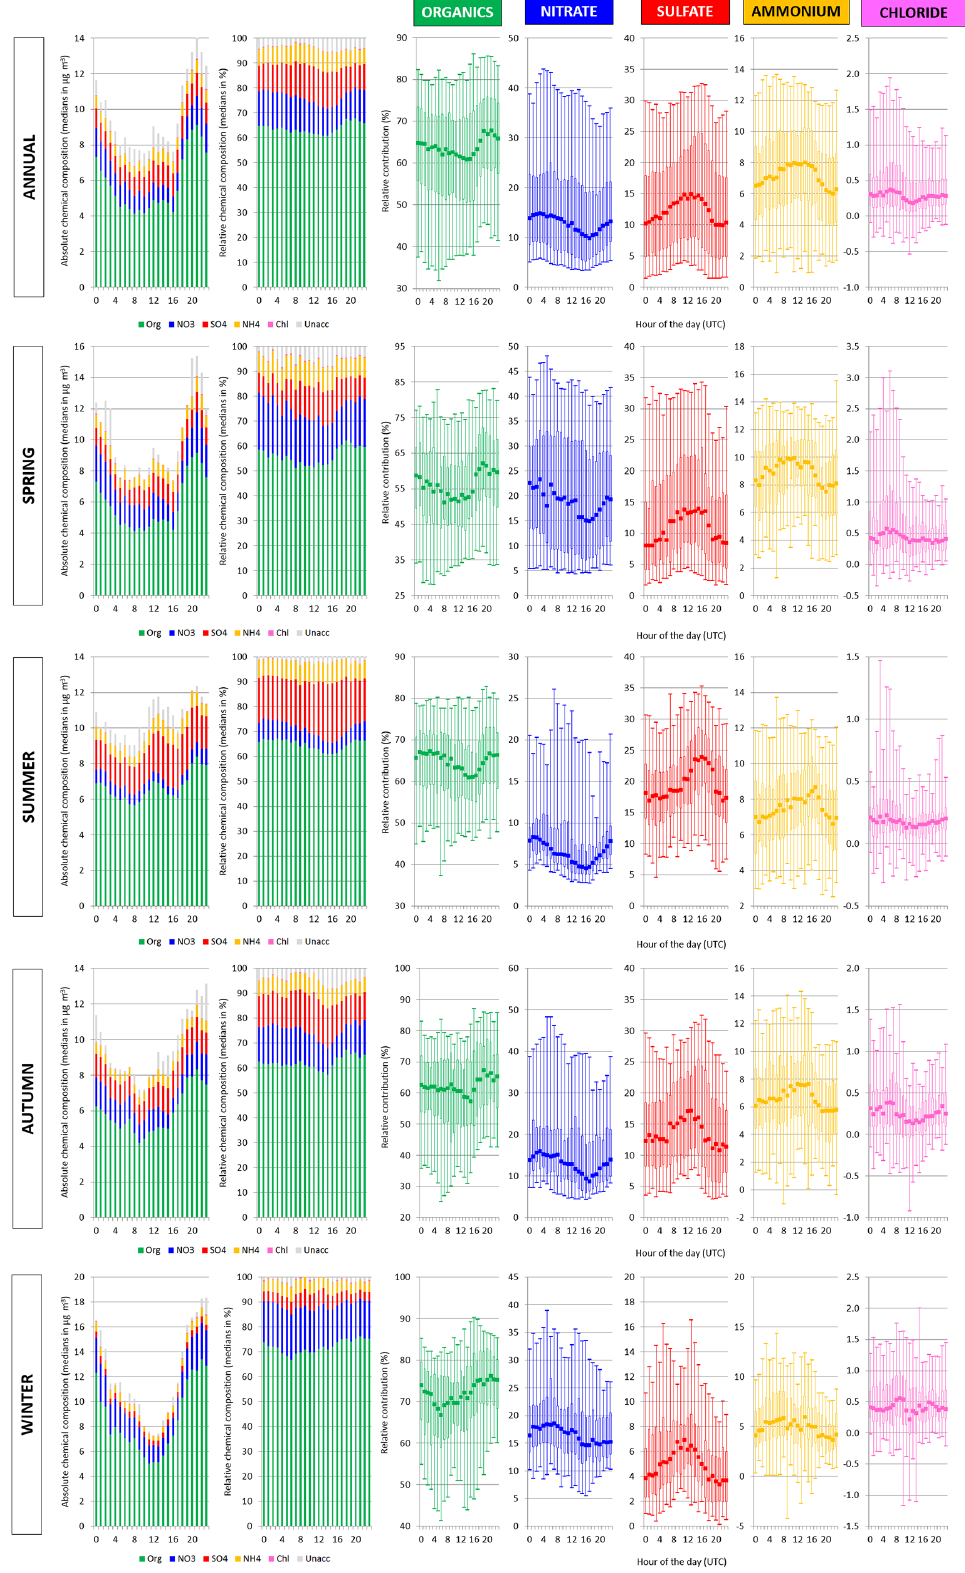
Figure 4. Daily cycles of NR-PM 1 chemical composition on the annual and seasonal scales. Unacc: unaccounted mass. Whisker plots are constructed from the 5th, 25th, 50th, 75th and 95th